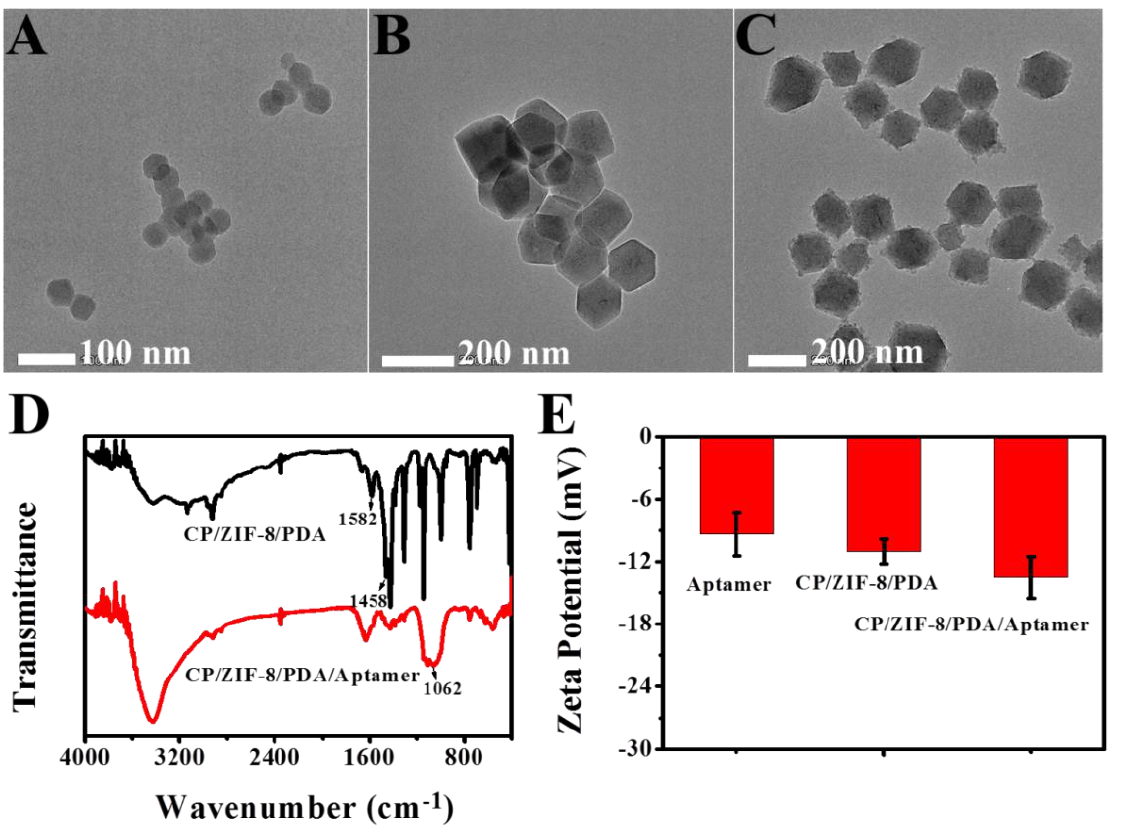
Figure 2. TEM image of ( A ) ZIF-8, ( B ) ZIF-8/CP, (C) CP/ZIF-8/PDA, and ( D ) FT-IR spectra of CP/ZIF-8/PDA, CP/ZIF-8/PDA/Aptamer; ( E ) Zeta potentials of CEA Aptamer, CP/ZIF-8/PDA and CP/ZIF- 8/PDA/Aptamer.